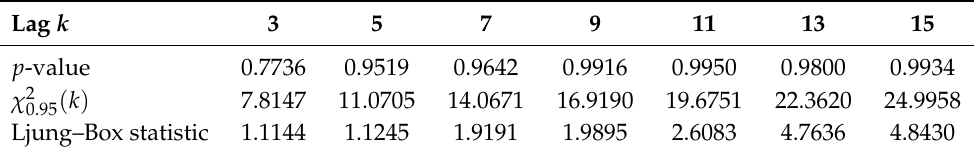
Table 2. Values of the Ljung–Box test for the measles